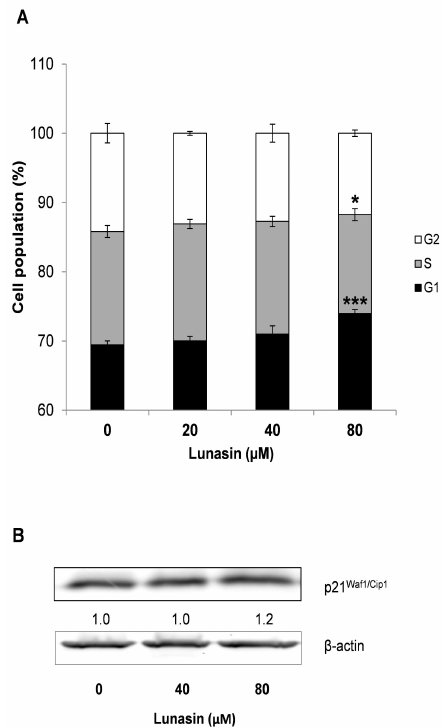
Figure 5. E ff ect of lunasin on cell cycle progression of colon tumorspheres. Cells were treated with lunasin at the indicated concentrations for 7 days, and harvested for cell cycle analyses and Western immunoblotting. ( A ) Cell cycle distribution was assessed by flow cytometry using PI staining. Results, presented as percentage of cells in G1, S, and G2 phases, are means ± standard deviation (SD) of the replicates of experiments carried out. * ( p < 0.05), *** ( p < 0.001) significantly di ff erent from control. ( B ) Expression of p21Waf1 / Cip1 protein determined by Western Blot. The numbers underneath the blots represent band intensity that was normalized to β -actin and measured by Image J software (means of duplicates, and standard deviations within ± 15% of the means were not shown). β -actin was served as an equal loading control for cytosolic